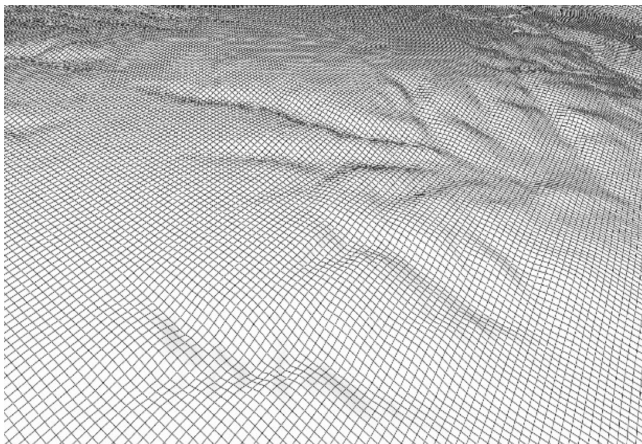
Figure 5. Partial mesh in computational domain.